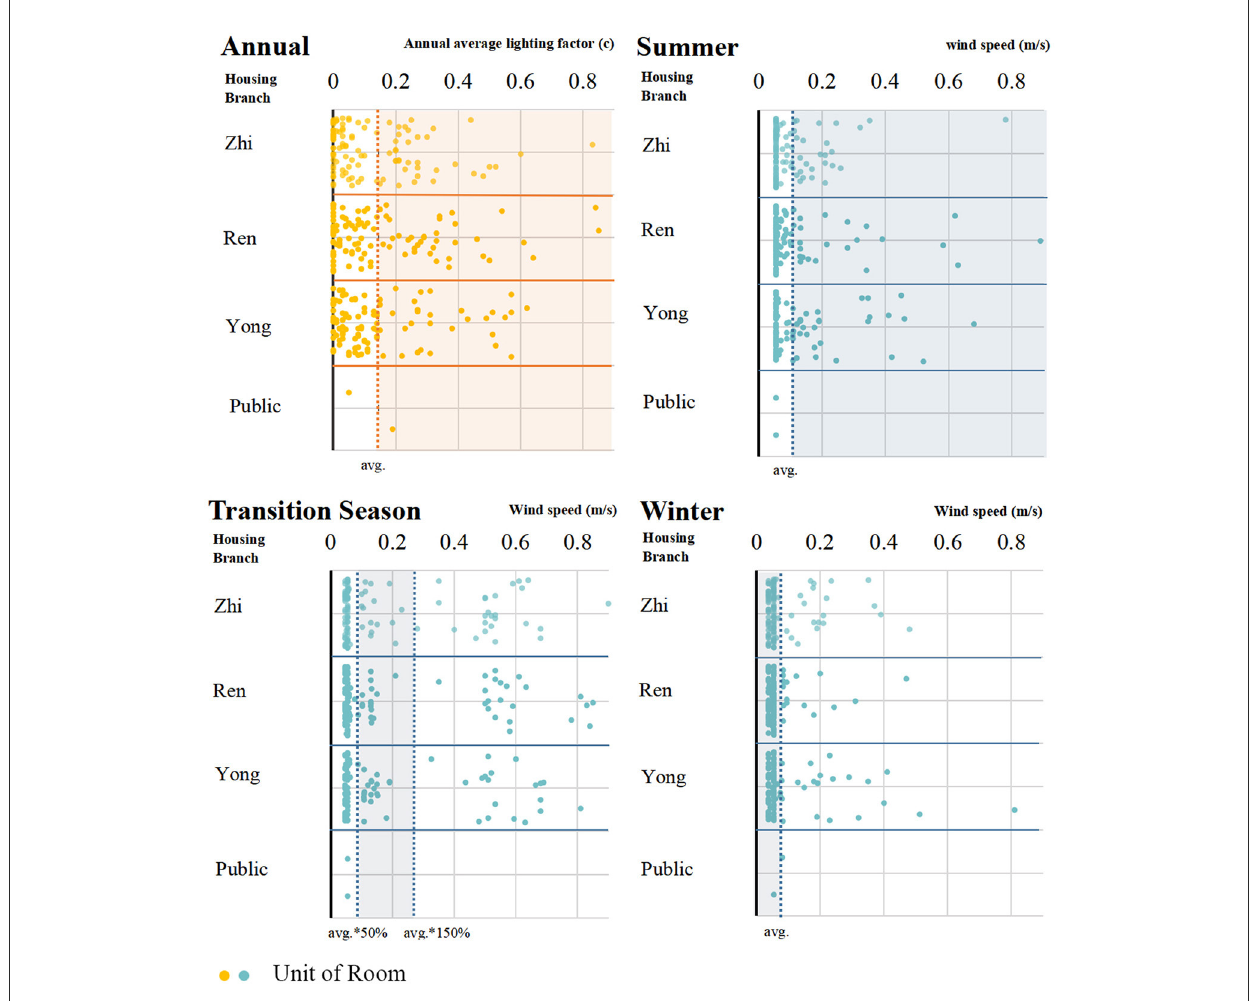
FIGURE8 Statistical chart of lighting and ventilation.